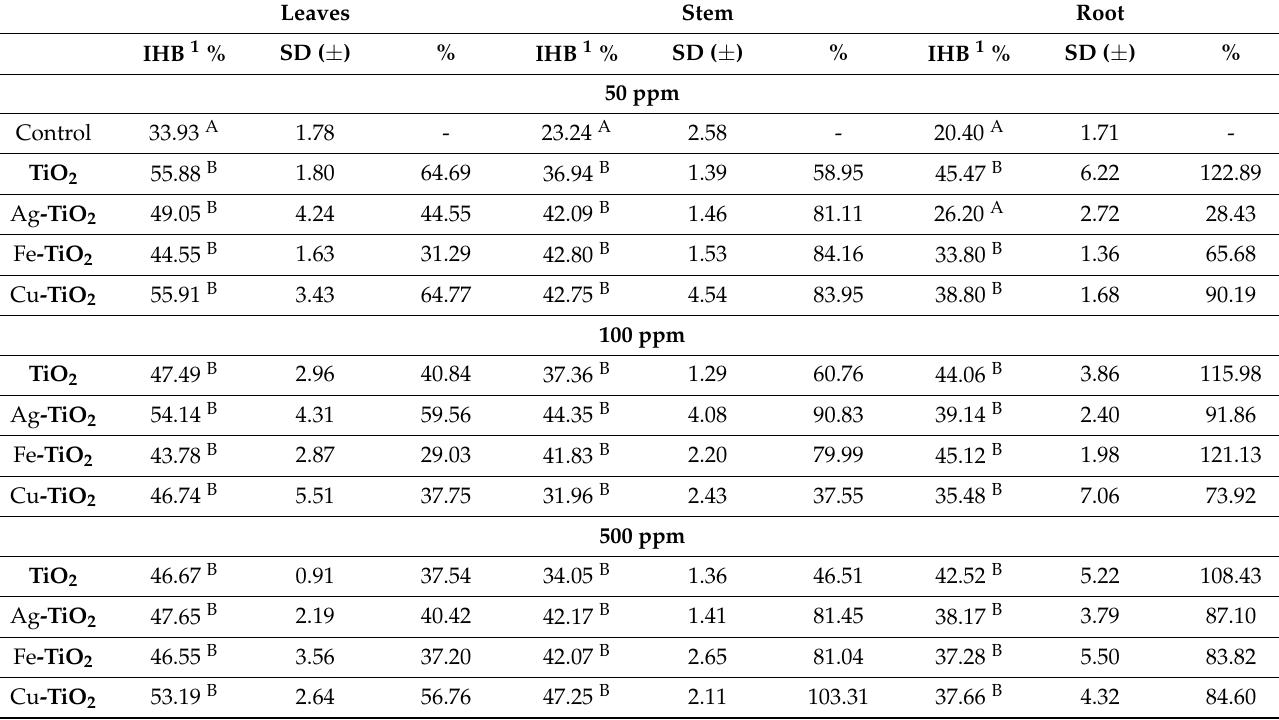
between means (Dunnett p ≤ 0.05). Means with different letters in the same column are statistically